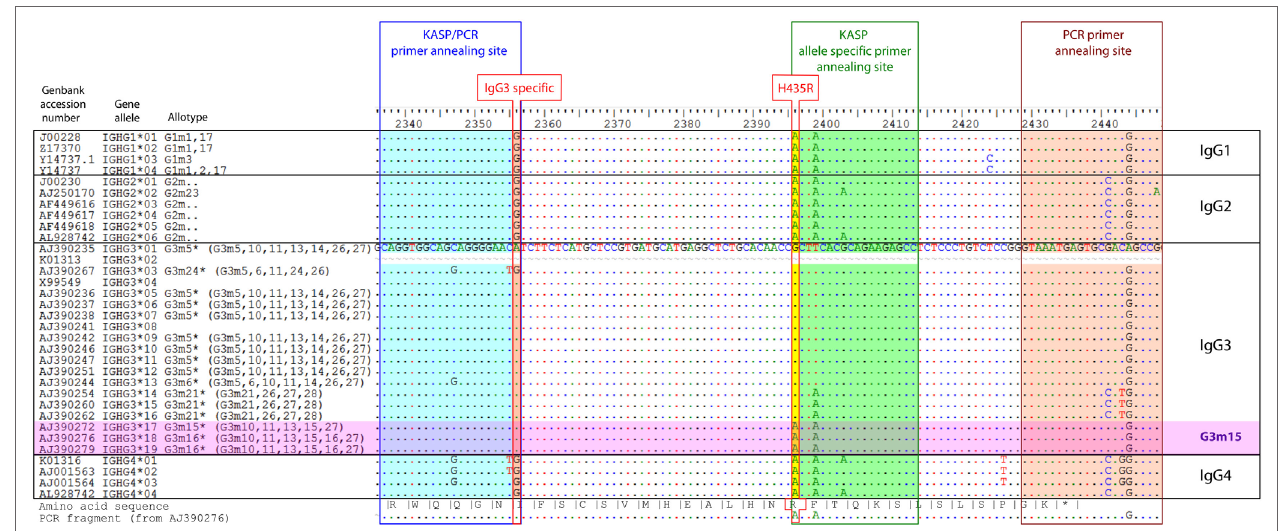
Figure 1 | Alignment of human IgG gene alleles. Alignment of all human IgG alleles listed in IMGT [http://www.imgt.org (Accessed: 15 March, 2015)], including GenBank accession number, gene names, isotype, allele numbering, and allotype numbering. Primer annealing sites for KASP and IgG3-specific PCR are shaded in blue, green, and red, respectively. Nucleotides unique in IgG3 (IgG3 specific) and the g.1053927G>A variation (p.Arg435His) are indicated with a red border. The full DNA sequence is shown for the reference sequence (AJ390235), for all other sequences, all bases except those that differ from the reference are masked by a dot. The amino acid sequence of the reference sequence is shown on the bottom site, together with the PCR fragment amplified for Sanger sequencing. The IGHG3 alleles that contain the g.1053927G>A variation are highlighted in pink (G3m15). A marker for DNA positions within the alignment set is given on the top scale.